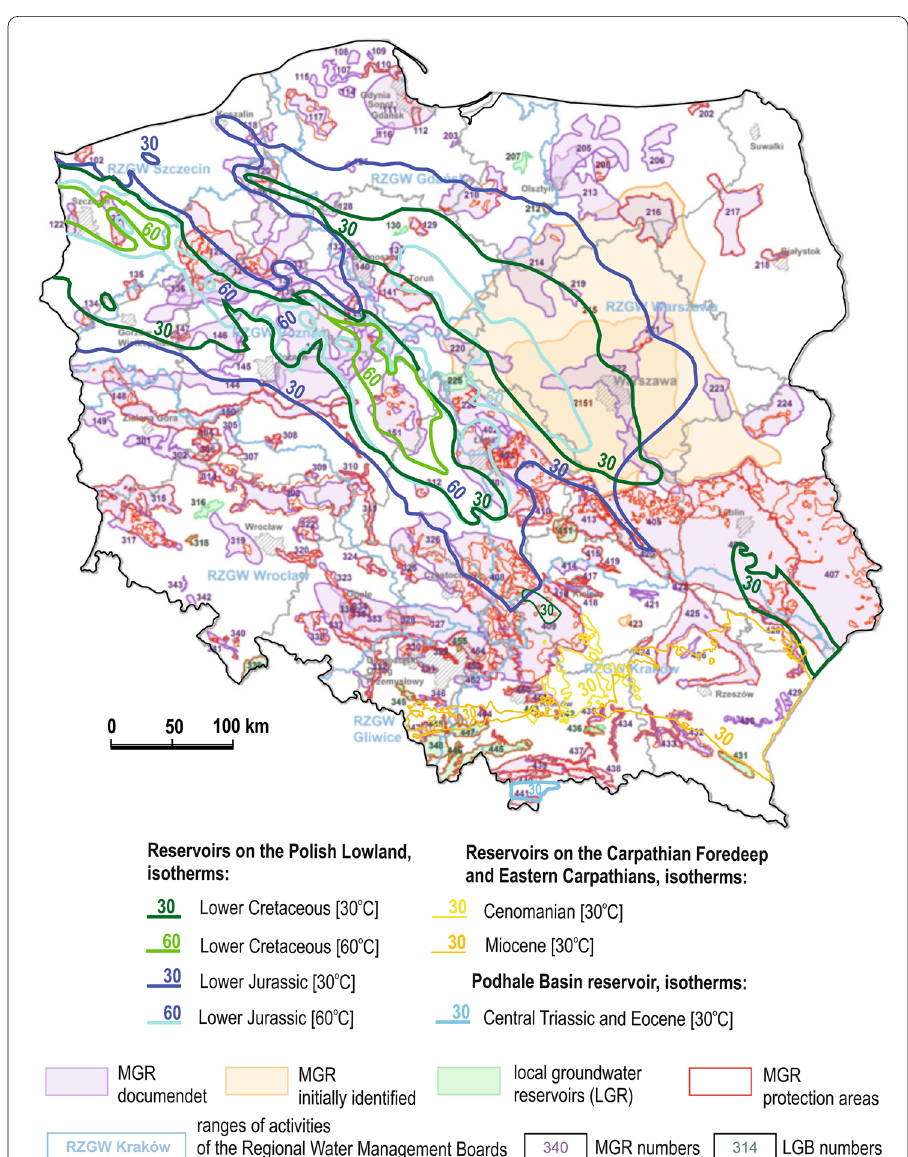
Fig. 4 Geothermal water reservoirs proposed for agricultural uses in Poland against the map of main groundwater reservoirs (MGR—fresh) and their protection areas. Scientific description based on Barbacki et al. (2016) ; ranges of reservoirs with temperatures > 30 ◦ C and > 60 ◦ C according to maps by Górecki et al. (2006, 2011, 2012, 2013); underlay Map of Main Groundwater Reservoirs (PGI‑NRI 2021)—data from November